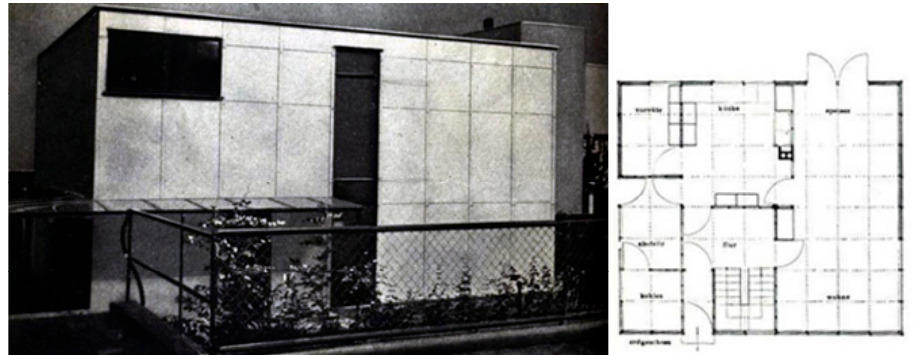
Figure 2. Experimental house by Walter Gropius for the Werkbund Exhibition in Stuttgart (house 17), 1927 [5].